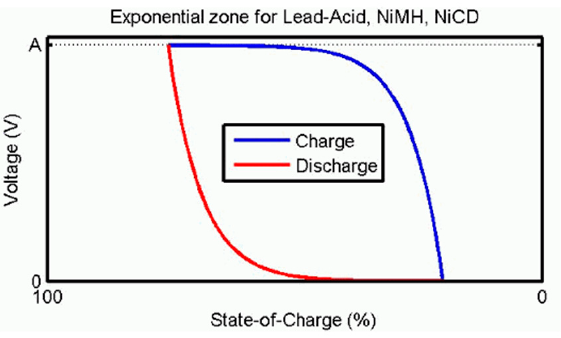
Figure 4. Hysteresis effect associated with the lead–acid battery.